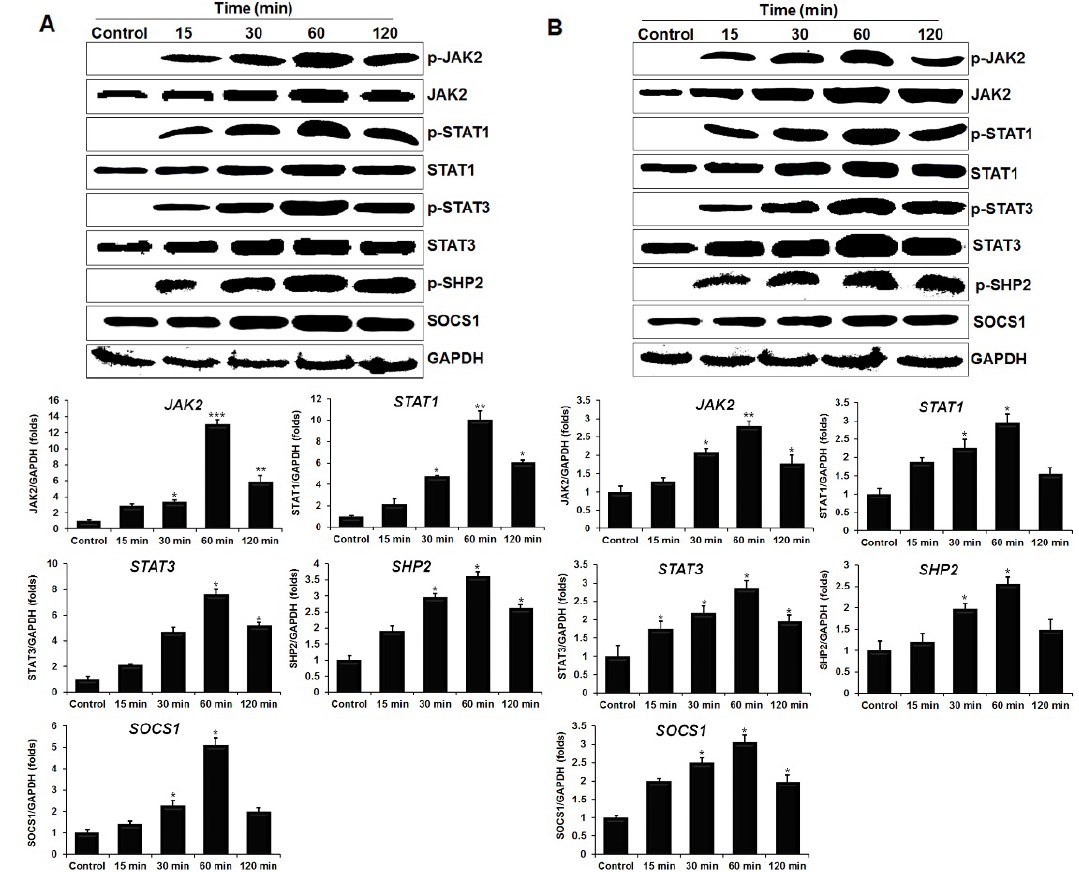
Figure 2. IL-34 activates the Janus kinase/signal transducer and activator of transcription (JAK/STAT) signaling pathway. The HD11 ( A ) and OU2 ( B ) cell lines were stimulated with or without IL-34 for 15, 30, 60, and 120 min. Total lysates were analyzed by western blot with antibodies against total or p-JAK/STAT signaling proteins (top). The changes in mRNA levels of JAK/STAT in cells treated with or without IL-34 were measured by qRT-PCR and levels were normalized to those of GAPDH (below). Data are presented as the mean ± SEM ( n = 3) of 3 independent experiments: * p < 0.05, ** p < 0.01, and *** p < 0.001.